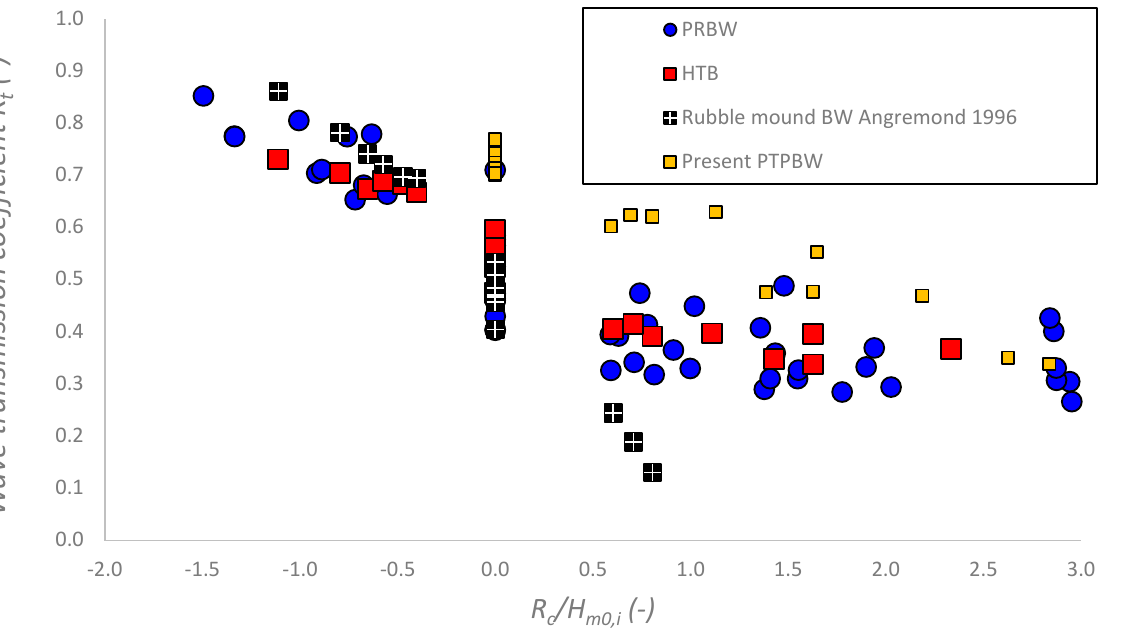
Figure 13 provides a comparison of wave transmission coefficients versus relative crest freeboards of different types of breakwaters. A comparison of the K t values between the HTB, PRWB, and rubble-mound breakwaters reveals that the transmission efficiency is low when the breakwaters are working in the emerging state. However, when breakwaters are submerged, the transmission coefficient of the rubble mound has the lowest value, with K t < 0.2. Rubble-mound breakwaters almost completely prevent incoming waves. Porous breakwaters, like HTBs and PRBWs, still enable waves to pass through the layer to a certain degree, and the transmission coefficients are almost unchanged, K t = 0.3–0.4. The PTPBW results presented in this figure correspond to the selected pore diameter (TH6, front-side porosity is 17.6%, D = 5.7 cm, and the back-side porosity is 12%, D = 4.1 cm). We note that although we favour the penetration of sediment-laden waters, the proposed PTPBW structure gives values of wave transmission coefficients that are comparable with the other structures. When R c / H mo,i > 2, the wave transmission coefficients given by the PTPBWs are nearly identical to those of the HTBs and PRBWs. This ensures that the main purpose of the PTPBWs is to facilitate sediment transport along the structure and stimulate sedimentation behind it.